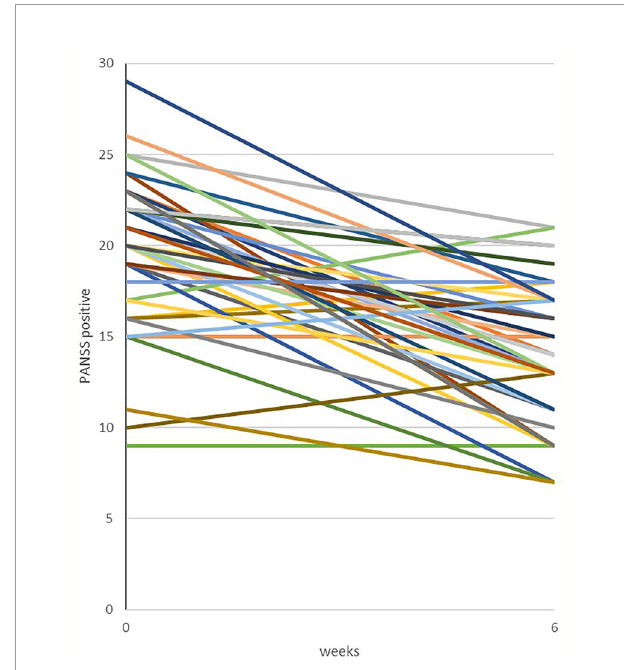
FIGURE 1 | Treatment response, amisulpride. Historical data from our group showing changes in PANSS positive symptoms in an independent cohort of 46 antipsychotic-naïve, fi rst-episode schizophrenia patients treated with amisulpride (mean dose of 279.4 mg/day) monotherapy for six weeks. Details on the cohort have previously been published, e.g.(Nielsen et al., 2012a; Nielsen et al., 2012b; Nielsen et al., 2016; Wulff et al.,